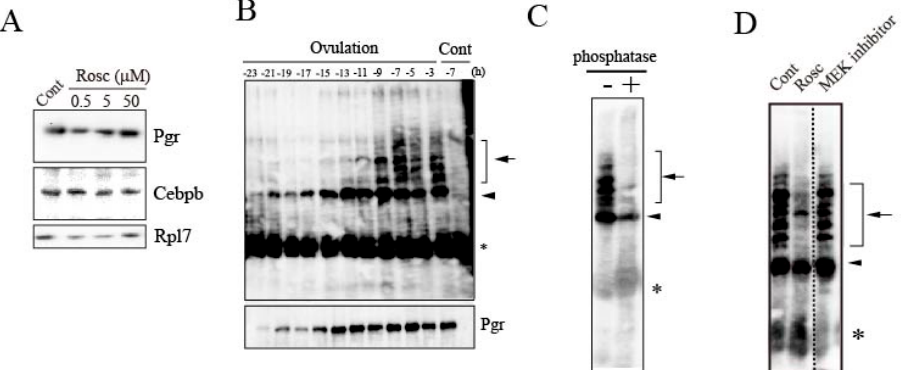
Figure 3. Roscovitine inhibition of Pgr phosphorylation in preovulatory follicles. ( A ) The − 14 h-follicles were incubated with roscovitine (Rosc) at 0.5, 5, or 50 µ M for 14 h, and the follicle layer extracts